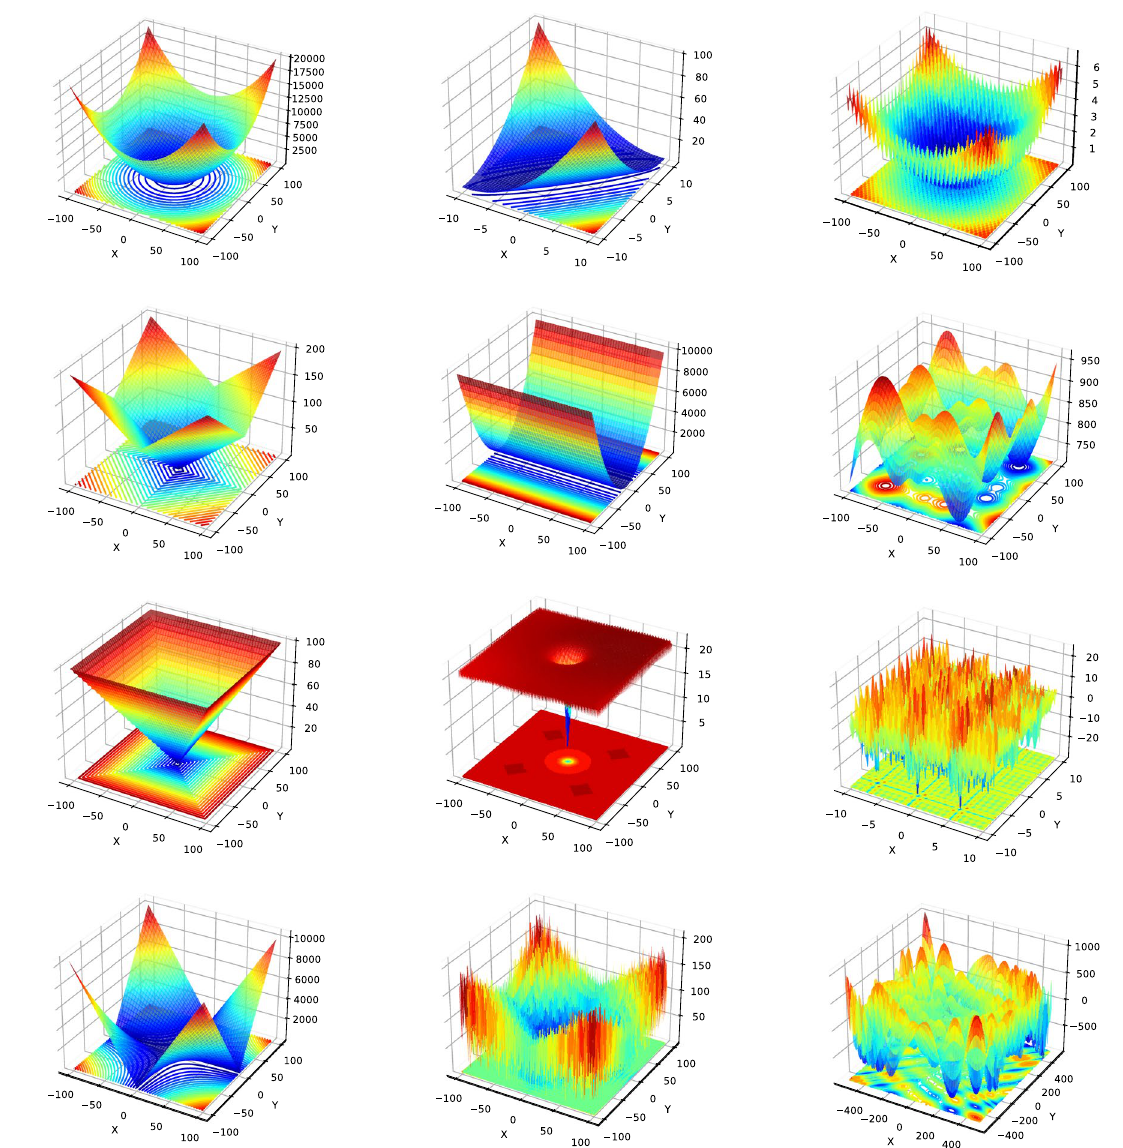
Fig. 4 Examples of 3D plot for some of benchmark